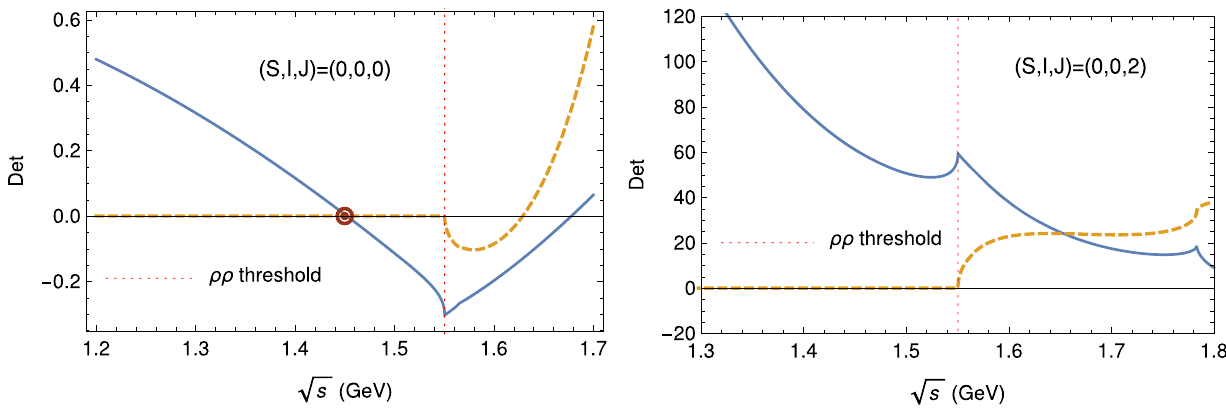
Fig. 8 Determinant of the D ( s ) matrix for the cases with ( S , I , J ) = ( 0 , 0 , 0 ) and ( 0 , 0 , 2 ) on the first Riemann sheet evaluated using q max = 0 . 875 GeV (real part: solid curve, imaginary part: dashed curve)